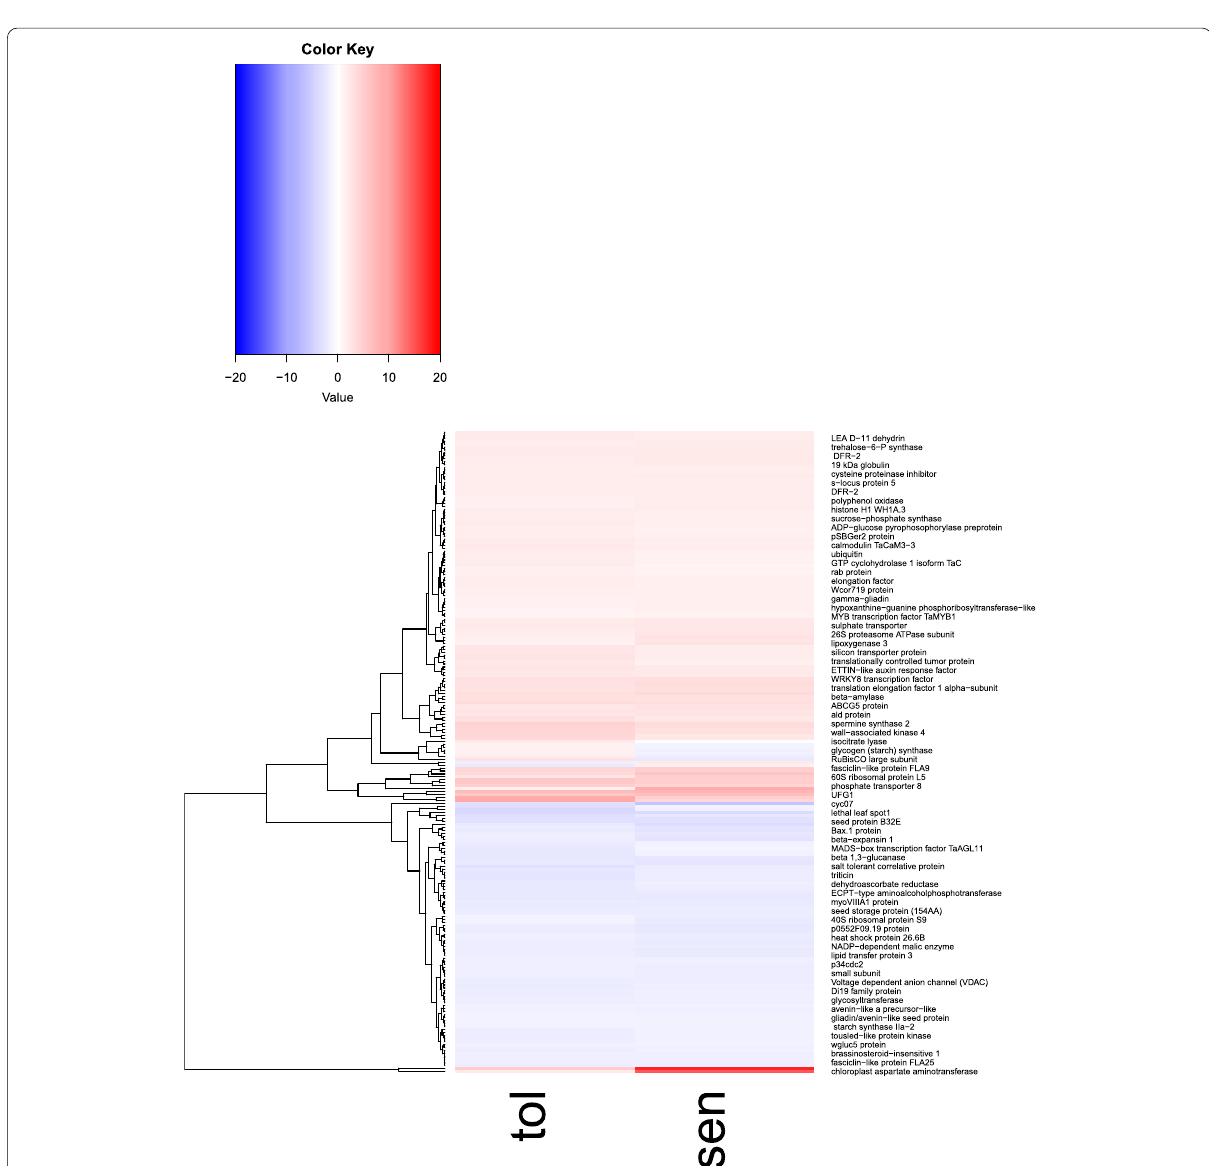
Fig. 7 Heat map of DEGs in the resistant and susceptible wheat cultivars. The red bars indicate increases and the blue bars indicate decrease expression